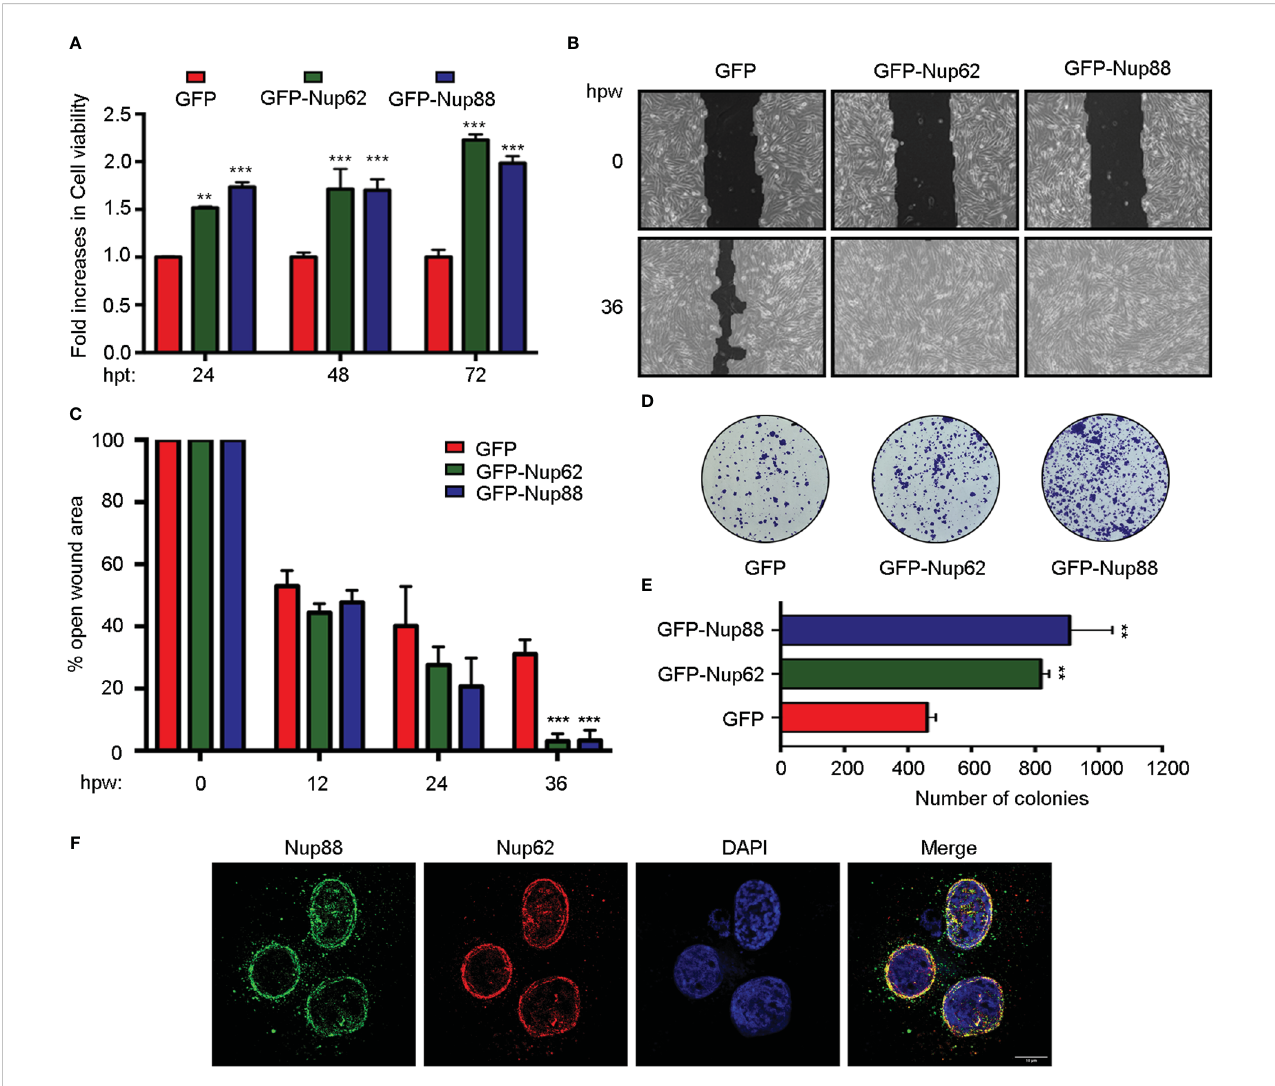
FIGURE 2 Overexpression of Nup88 and Nup62 induces tumorigenic transformations. (A) MTT assay based cell viability assessment in GFP, GFP-Nup62, and GFP- Nup88 transfected SCC9 cells. (B) Representative images of 0 h and 36 h wound healing assay in SCC9 cells expressing GFP, GFP-Nup62, and GFP- Nup88. The images were acquired at 10X magni fi cation under an inverted microscope. (C) Quanti fi cation of the closure of the wound area at 0, 12, 24, and 36 h as seen in (B) using TScratch software. (D) Colony formation assay in H413 cells overexpressing GFP, GFP-Nup62, and GFP-Nup88. (E) Quanti fi cation of the number of colonies using Image-J/Fiji software. (F) Immunolocalization analysis of Nup88 and Nup62 in oral cancer cell line H413, anti-Nup88 (green), anti-Nup62 (red) and chromatin/DAPI (blue). Scale bar = 10 µm. Images are a representative from at least n=3 repeat experiments. Error bars show mean values ± SEM. Asterisks indicate statistical signi fi cance (Student ’ s t-test) *p < 0.05, **p < 0.01 and ***p <